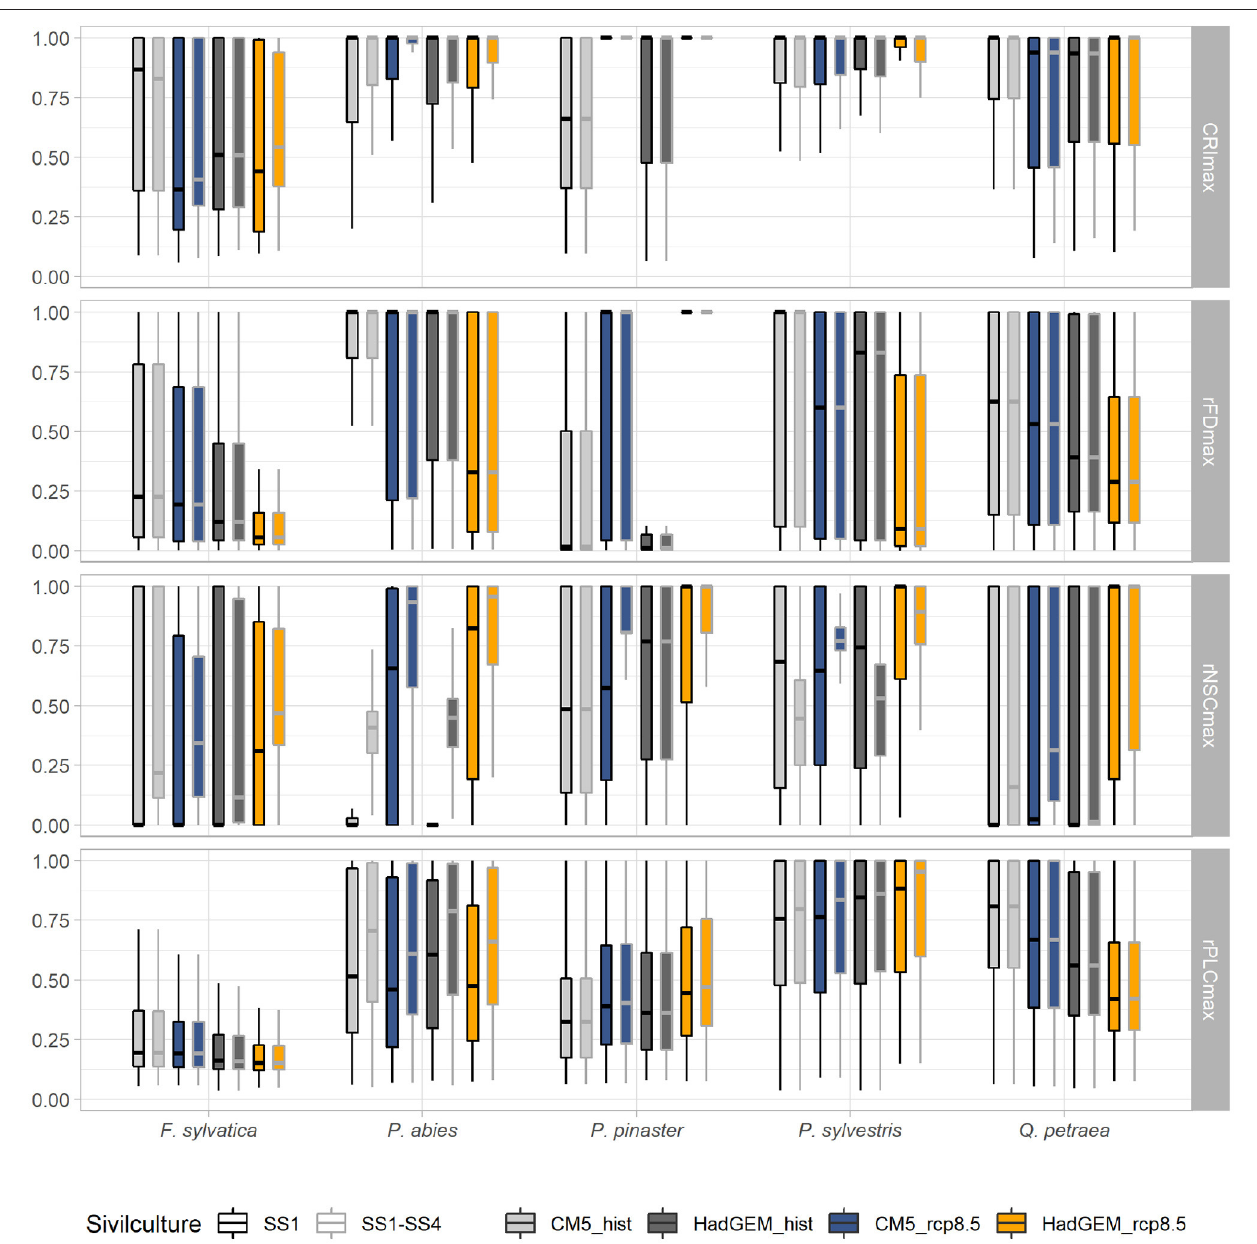
FIGURE 6 | Variation of the mean values of mortality risk indices ( CRIM max , rFD max , CRIM max , and rPLC max ) under two current (CM5-hist in light gray and HadGEM-hist in dark gray) and two future (CM5-8.5 in blue and HadGEM-8.5 in orange) climatic scenarios. Each scenario with locally prescribed silviculture (i.e., four possible silvicultural systems) is represented with gray whisker box contouring, and can be compared to its reference without management (i.e., SS1), with black contouring. See legend of Figure 3 for whisker